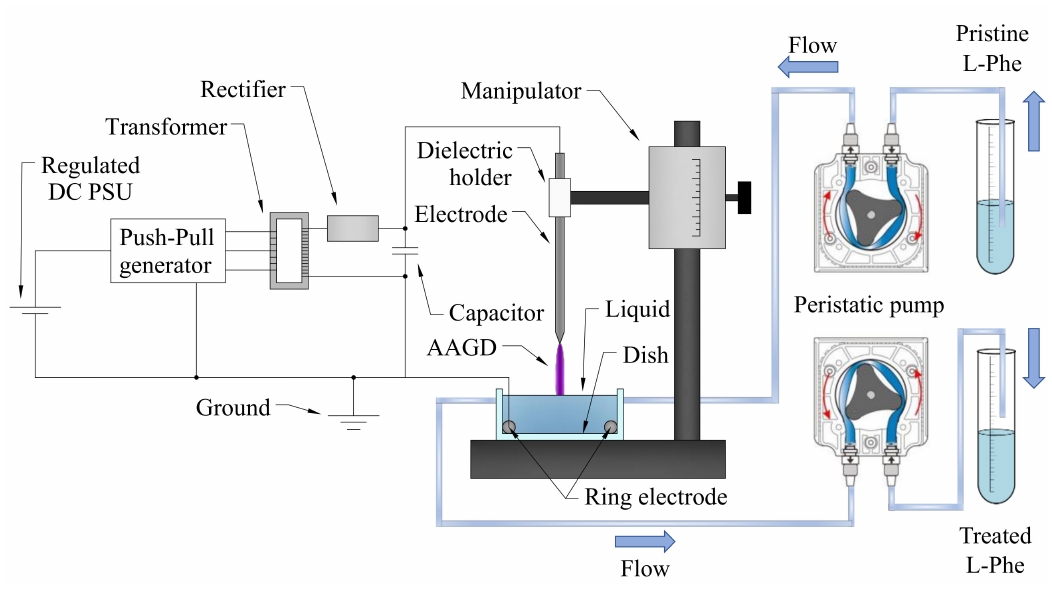
Figure 1. Experiment